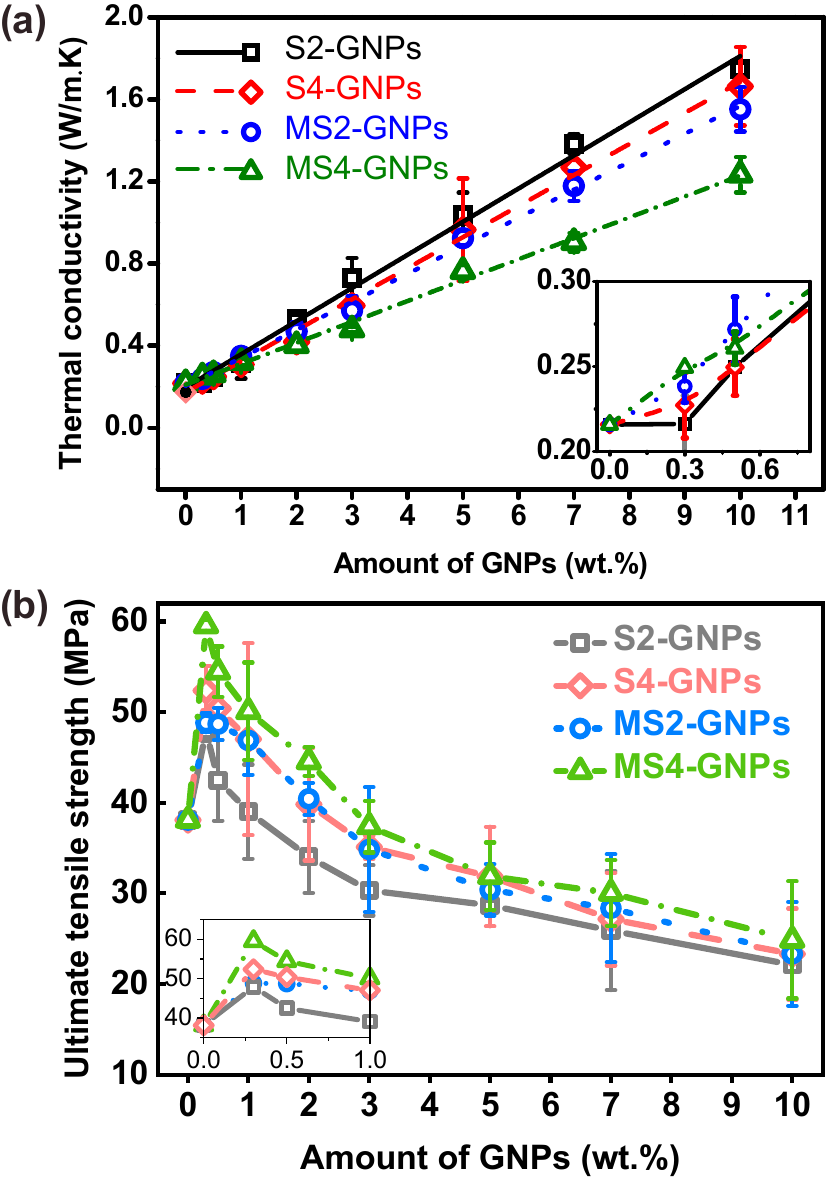
Figure 5. ( a ) Thermal conductivities and ( b ) ultimate tensile strengths of composites with varying amounts of S2-, S4-, MS2-, and MS4-GNP fillers. The inset in ( a , b ) shows the magnified graphs at low GNP concentrations.